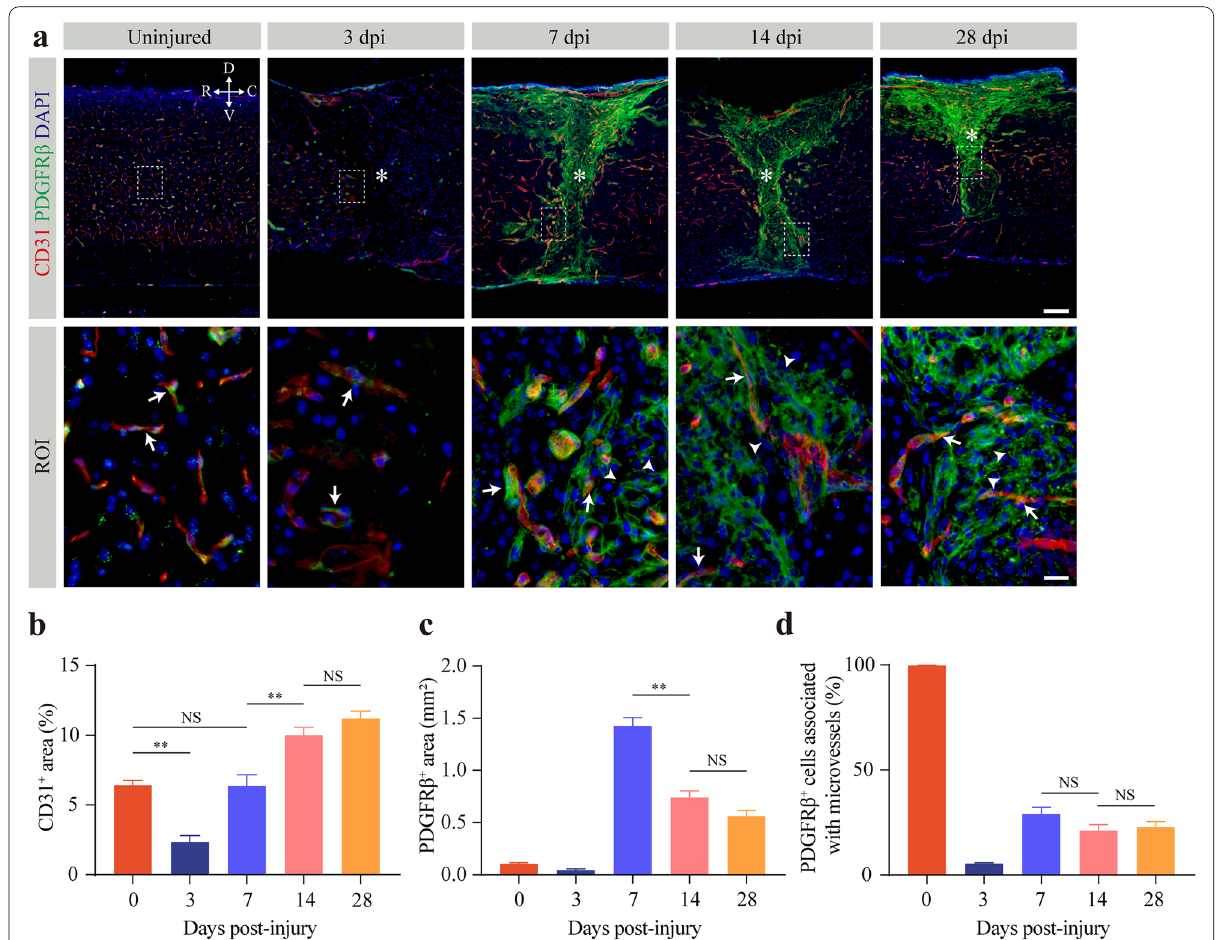
Fig. 1 Pericytes detach from the vascular wall and contribute to fibrotic scarring after SCI. a Representative immunofluorescence images of microvessels (CD31, red), pericytes (PDGFRβ, green), and DAPI (blue) in the spinal cord of uninjured mice and injured mice at 3, 7, 14, and 28 days post‑injury (dpi). High magnification images of the dotted area are shown below as the region of interest (ROI). The asterisks denote the lesion core. PDGFRβ + pericytes are tightly connected (arrows) with or detached from (arrowheads) the vascular wall. Scale bars: 100 μm (upper panel) and 20 μm (lower panel). All images are from sagittal sections. b–d Quantification of the percentage of CD31 + microvessel area ( b ), PDGFRβ + pericyte area ( c ), and PDGFRβ + cells associated with microvessels ( d ) in the lesion core after SCI. n 4 per time point. Data are shown as mean s.e.m. NS, no = ± significance; ** p < 0.01 by one‑way ANOVA followed by Tukey’s post hoc test in b – d . D, V, R, and C represent the dorsal, ventral, rostral, and caudal sides of the injury,